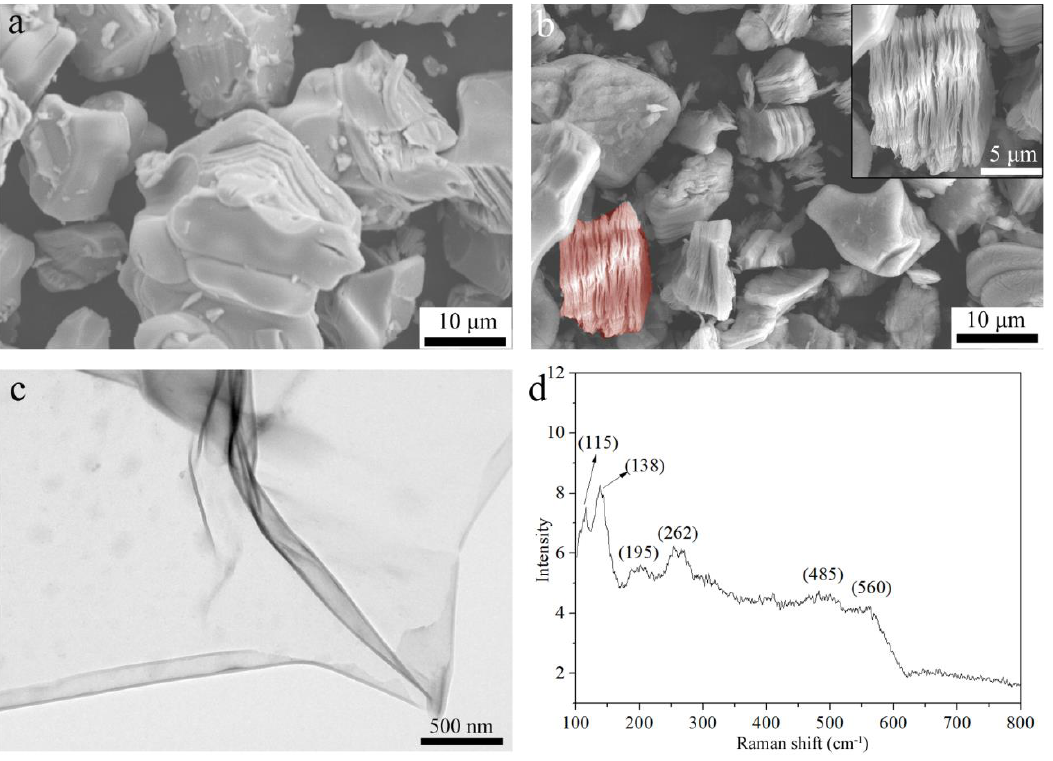
Figure 2. SEM ( a , b ) and TEM ( c ) images and Raman spectrum ( d ) of samples. ( a ) V 2 AlC, ( b – d ) exfoliated product in NaF + HCl. The inset is an enlarged image of ( b ).